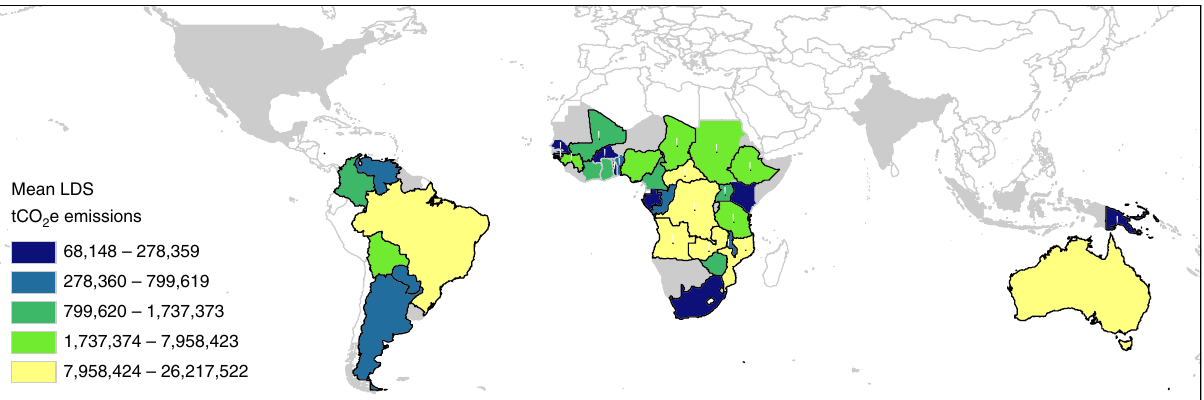
Fig. 2 Prospective countries for early dry season savanna burning. Prospective countries for early dry season (EDS) savanna burning where colors are scaled by mean country level late dry season (LDS) emissions (using quantile bins). Heavy black outline shows countries with >50% LDS emissions and black circle symbols shows least developed countries (LDC) and small island developing (SID) countries Table 4 African least developed countries (LDCs) suitable for piloting EDS savanna burning where LDS emissions >50,000 tCO 2 -e yr − 1 and Protected Areas>1000 km 2 Country Mean EDS (tCO 2 -e yr − 1